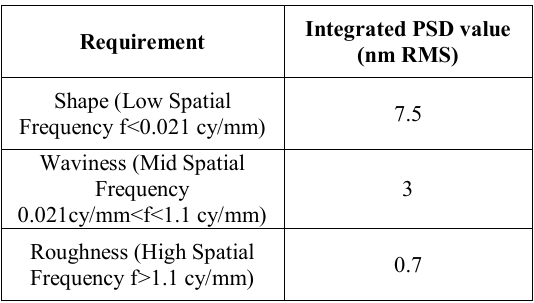
Table 1 : NOPT mirror PSD requirements after polishing